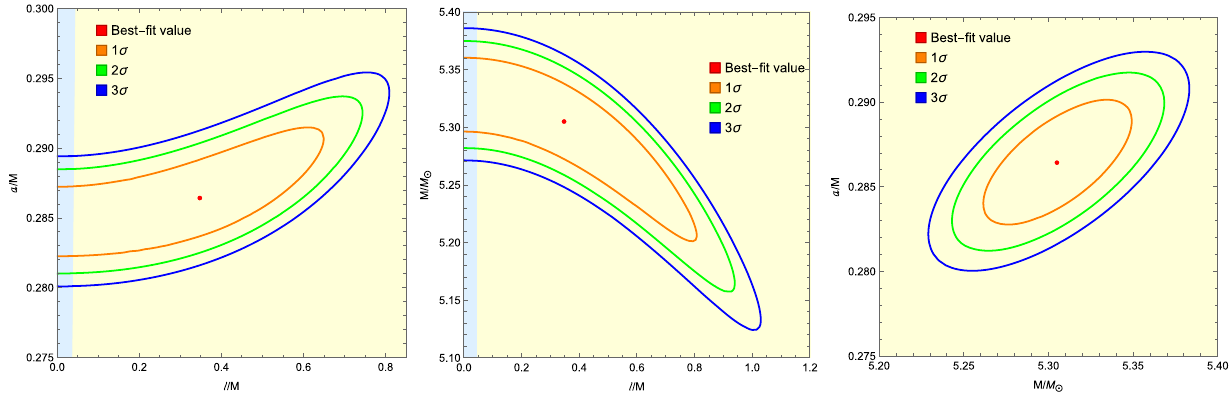
Fig. 3 Estimate of the mass M / M (cid:6) , of the spin parameter a / M and of theparameter (cid:5)/ M oftherotatingSVmetric,whichdescribesthespace- time around the compact object in GRO J1655-40, from interpreting the observations of QPOs in the RPM. Specifically, the best-fit values (red dots)andthecontourlevelsof1 σ (orangelines),2 σ (greenlines)and3 σ (blue lines) for the parameters are shown in the (cid:5)/ M - a / M (left panel), (cid:5)/ M - M / M (cid:6) (middle panel) and M / M (cid:6) - a / M (right panel) planes. In the yellow and blue regions, the rotating SV metric represents regu-